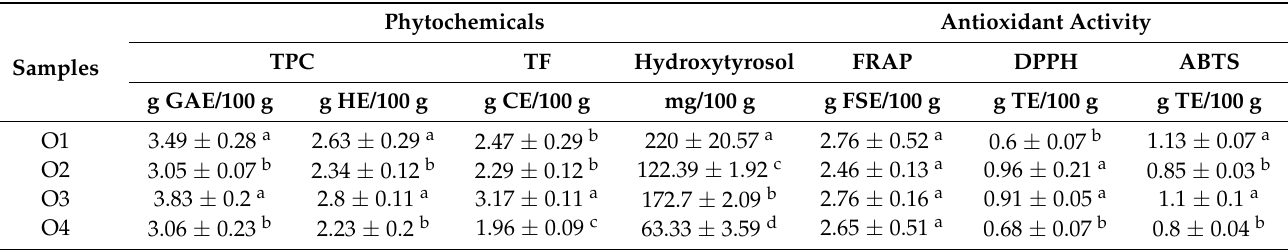
Table 2. Total phenolics; flavonoids; hydroxytyrosol content and antioxidant activity (FRAP, DPPH and ABTS) of the olive pomace extracts (dry weight).